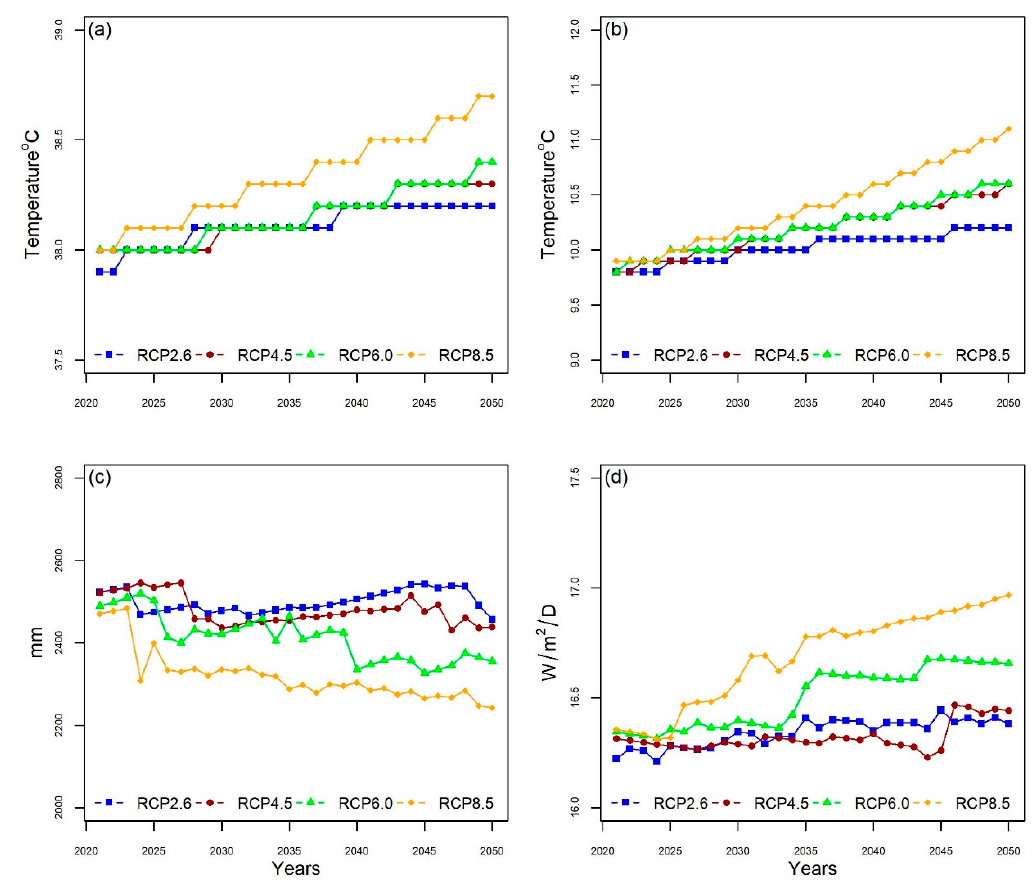
Figure 3. Future climate predictions under different scenarios for ( a ) maximum temperature, ( b ) minimum temperature, ( c ) annual rainfall, and ( d ) solar